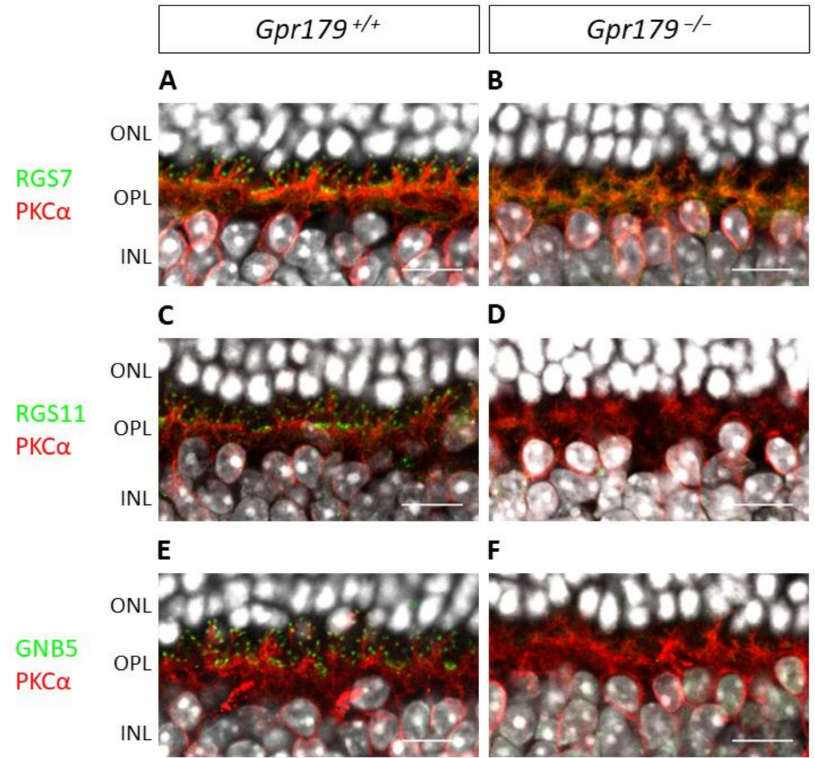
Figure 8. Localization of RGS11, RGS7, and GNB5 at the dendritic tips of ON-bipolar cells is dependent on Gpr179 expression. Representative confocal images of Gpr179 +/+ and Gpr179 − / − mouse retinal sections. Gpr179 +/+ ( A ) and Gpr179 − / − ( B ) mouse retinal sections were stained with anti-RGS7 (green), anti-PKC α (red), and DAPI (white). Gpr179 +/+ ( C ) and Gpr179 − / − ( D ) mouse retinal sections were stained with anti-RGS11 (green), anti-PKC α (red), and DAPI (white). Gpr179 +/+ ( E ) and Gpr179 − / − ( F ) mouse retinal sections were stained with anti-GNB5 (green), anti-PKC α (red), and DAPI (white). Scale bar: 10 µ m, ONL: outer nuclear layer; OPL: outer plexiform layer; INL: inner nuclear